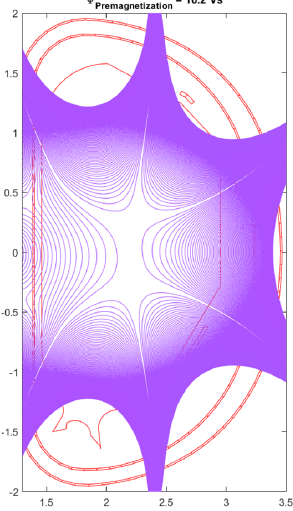
Figure 2. DTT premagnetization with a poloidal flux of 16.2 Vs.